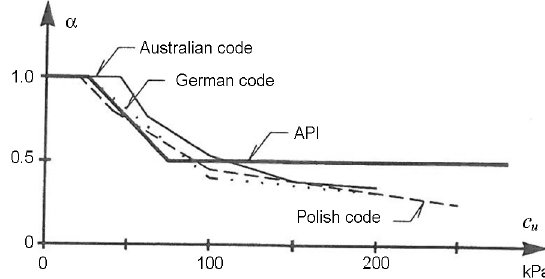
Fig. 12. α -values obtained using different